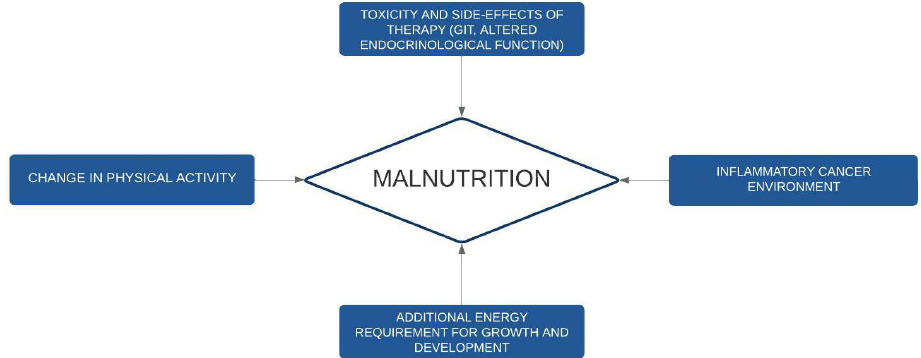
Figure 1. Pathogenesis of undernutrition in childhood cancer. GIT: gastrointestinal toxicities.